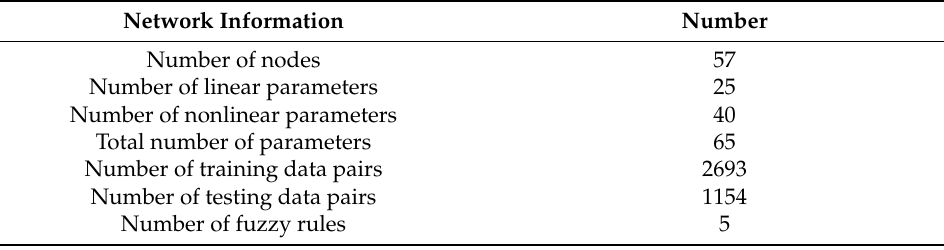
Figure 2. Structure of the ANFIS network applied in this study to predict the RSFC in winter. Table 4. ANFIS network information used in this